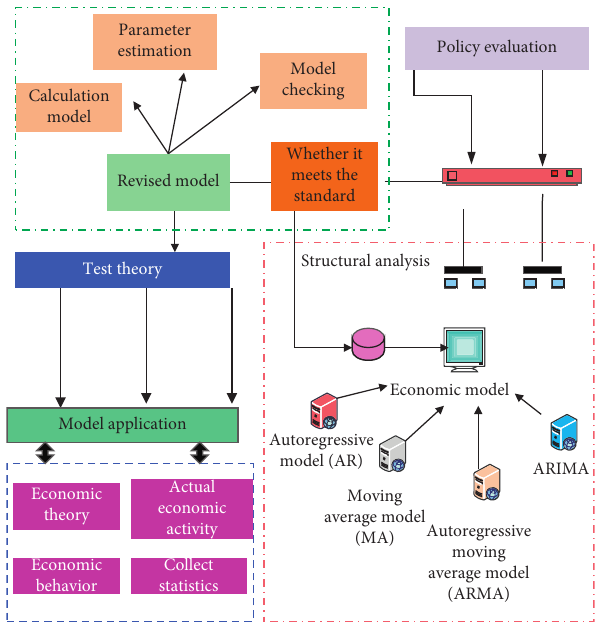
Figure 1: Schematic diagram of econometrics research